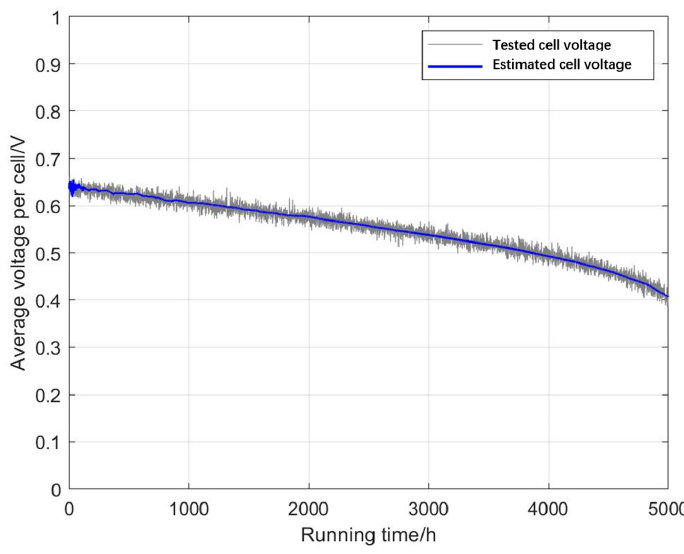
Figure 3. Voltage degradation and estimation (5000 h).